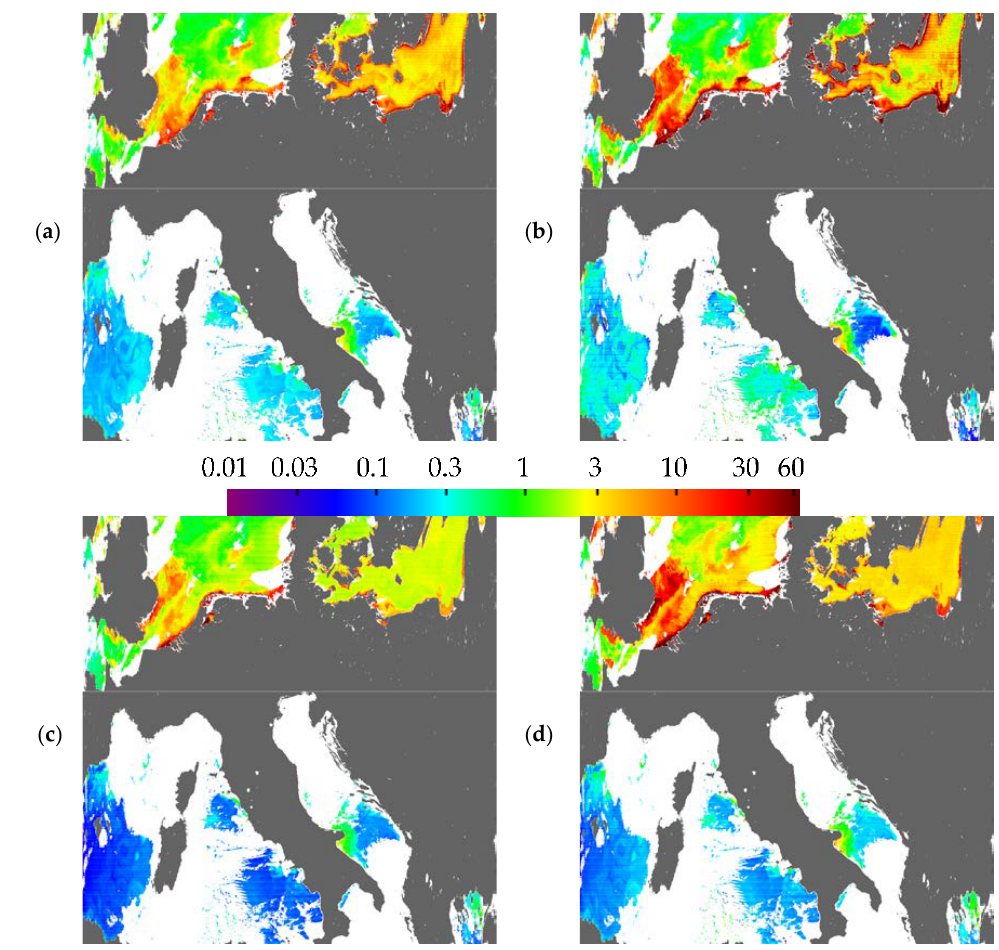
Figure 4. ( a ) Chl SAT (mg m −3 ) from a MODIS-Aqua overpass on 5 May 2013 at 12:10 (original satellite projection at ~1 km resolution, central section removed); ( b ) overall uncertainty in chl SAT , chl SAT × √ (bias 2 + standard deviation 2 + standard error 2 ), estimated using GAMLSS; ( c ) chl SAT with bias subtracted; ( d ) uncertainty in bias-subtracted chl SAT , chl SAT × √ (standard deviation 2 + standard error 2 ).